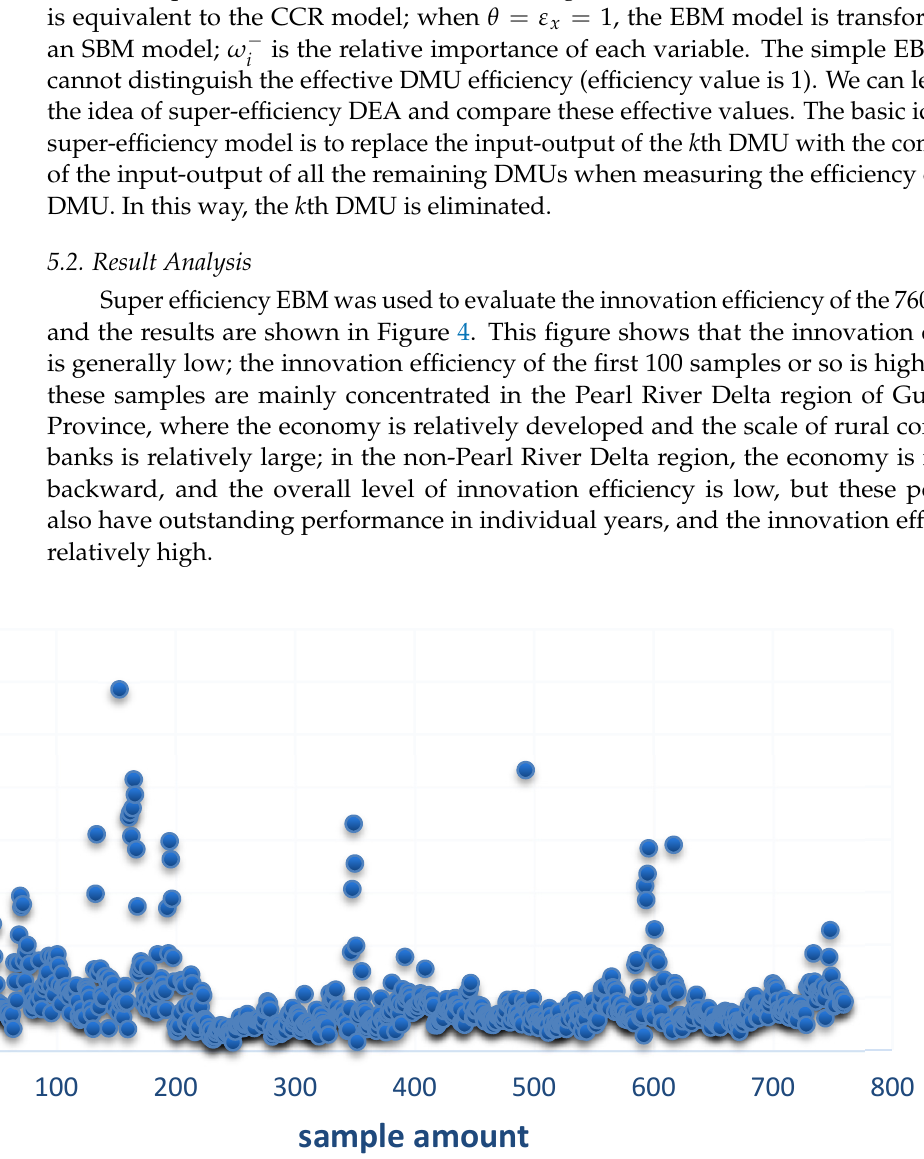
Figure 5. Trend of annual average efficiency. 6. Further Discussion 6.1. The Impact of Input Variables on Output and Efficiency After completing the calculation of efficiency, we compared the relationship between input variables and output and between input variables and efficiency, respectively, so as to identify input variables that may have inconsistent impact directions. If such a variable existed, the economic significance behind it was explored. A static effect panel model was used to analyze the impact of input on innovation efficiency. Since the unit of input variables is relatively large, all input variables were di- vided by 10,000. The F test result was significant, so the mixed regression (pooled OLS)